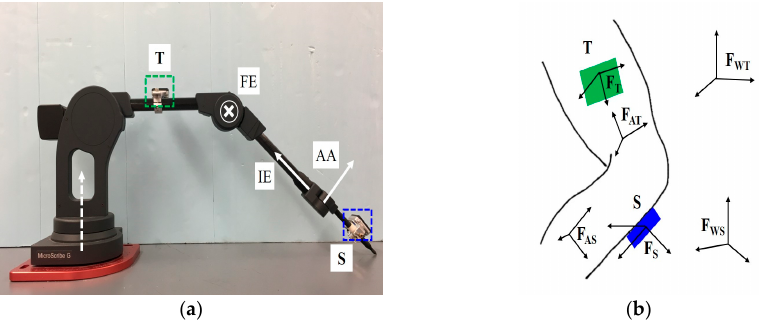
Figure 1. Knee analog formed by a coordinate measuring machine (CMM). ( a ) Three anatomical axes for flexion/extension (FE), internal/external rotation (IE), and abduction/adduction (AA) are labeled at the corresponding rotational joints of the CMM. Two labeled IMUs are mounted to the CMM with T (green) analogous to a thigh-mounted IMU and S (blue) analogous to a shank-mounted IMU. ( b ) Definitions of three frames of reference for a human knee associated with a shank-mounted IMU (blue) including the shank IMU frame, F S , the shank anatomical frame, F AS , and the shank IMU’s world frame, F WS . Analogous frames of reference are illustrated for the thigh-mounted IMU